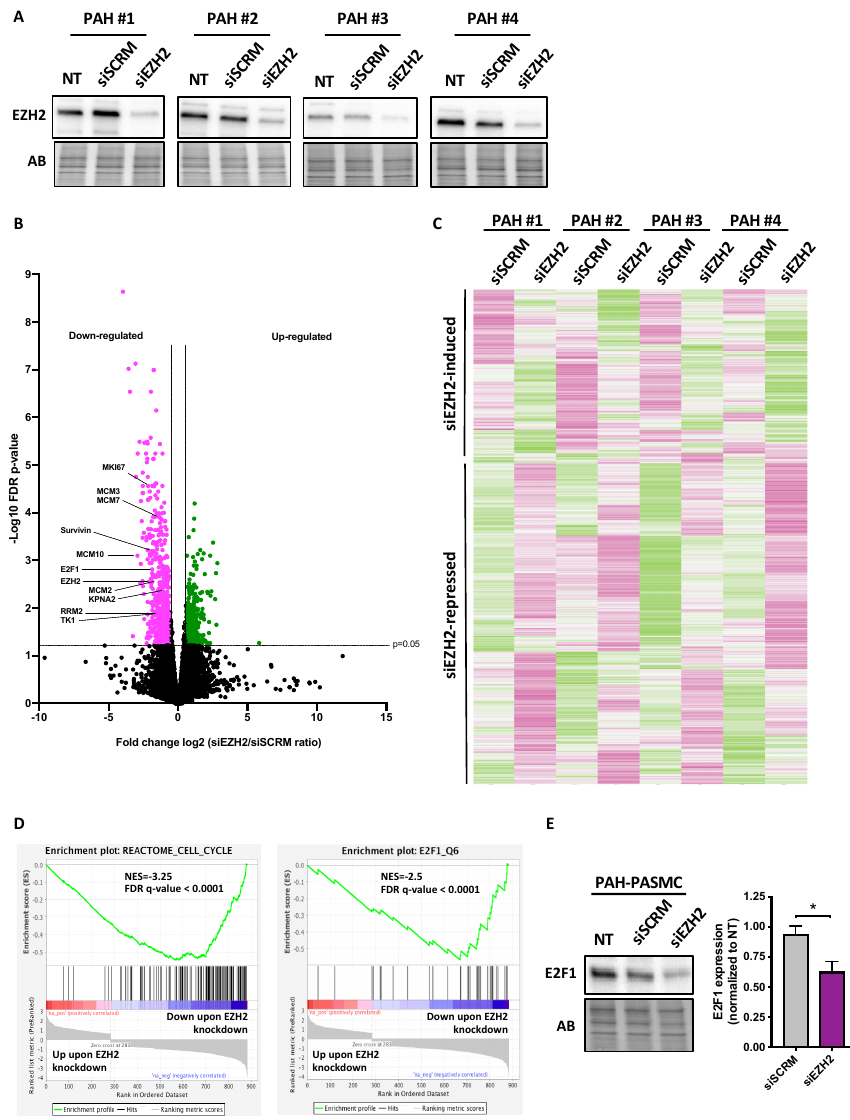
Figure 3. EZH2 knockdown in PAH-PASMCs and quantification of global transcript abundances by RNA sequencing. ( A ) Western blots of EZH2 in four different PAH-PASMC cell lines transfected or not with a siRNA targeting EZH2 (siEZH2) or a scrambled control siRNA (siSCRM). EZH2 siRNA markedly reduces EZH2 levels in the four PAH-PASMC cell lines; ( B ) Volcano plot comparing the transcriptome of siSCRM and siEZH2-treated PAH-PASMCs. Vertical lines indicate a fold change ± 1.5 and the horizontal line is indicative of a false-discovery-rate value threshold of 0.05. Pink (downregulated) and green (upregulated) points: transcripts that meet both criteria for significant change (i.e. FDR < 0.05 and fold change > 1.5) between control and EZH2-depleted cells; ( C ) Heatmap representation of all mRNAs whose expression levels were significantly impacted (FDR < 0.05) after silencing of EZH2 by a fold change > 1.5 or <1.5. The columns represent the results of four independent PAH-PASMC cell lines transfected with siSCRM and siEZH2. Rows show individual differentially expressed genes. The color key from pink to green represents transcript abundance from low to high. Selected genes are marked on the right side; ( D ) Selected gene set enrichment analysis (GSEA) charts showing enrichment for genes in the cell cycle process and E2F1 targets. The top portion of each panel represents the normalized enrichment score (NES) for each gene; the bottom portion of the plot shows the value of the ranking metric moving down the list of ranked genes; ( E ) Western blot showing expression levels of E2F1 in PAH-PASMCs subjected or not to EZH2 knockdown for 48 h. Quantitative densitometric analysis is shown. Protein expression was normalized to Amido black (AB). Data are presented as mean ± SEM; * p <